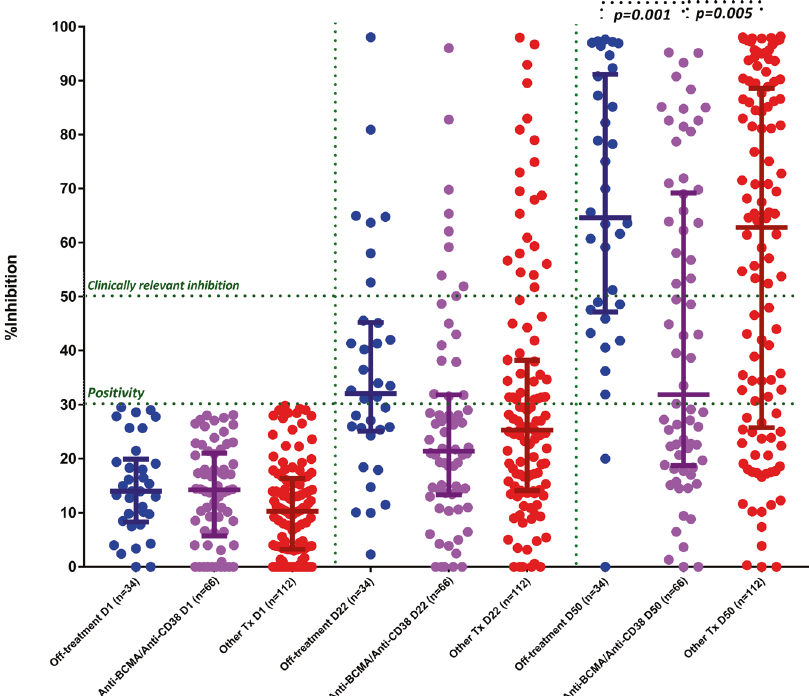
Fig. 4 Kinetics of NAbs in symptomatic MM patients on treatment with Belantamab mafodotin or anti-CD38-based combinations compared with MM patients off treatment and MM patients on treatment with other therapeutic regimens. Patients on Belantamab mafodotin or anti-CD38 combinations had signi fi cantly lower NAbs on day